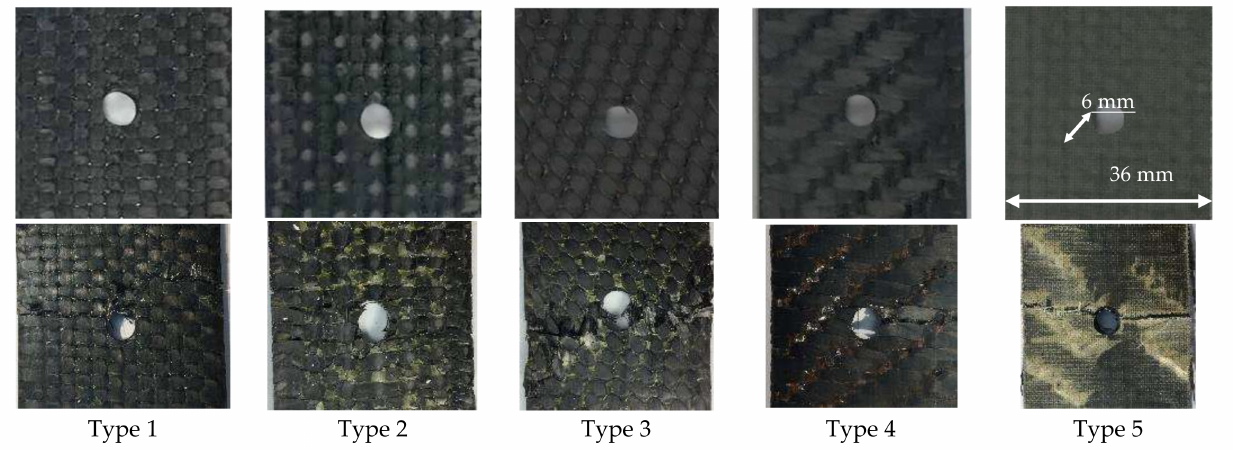
Figure 5. Photographs of CFRP samples in the vicinity of the concentrator before and after tensile